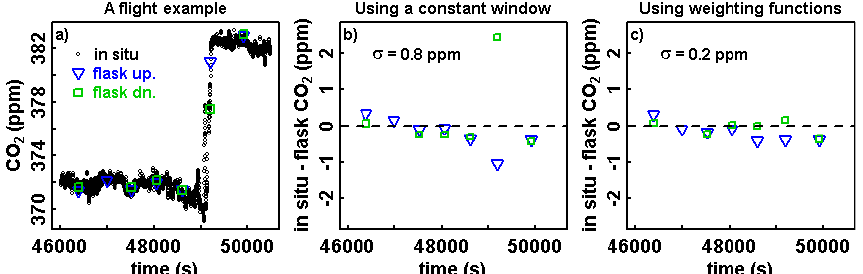
Fig. 8. An example of the performance of these weighting functions for the flight on 20 August 2008: (a) in situ measurements of CO 2 mixing ratios with flask CO 2 mixing ratios shown in blue (upstream) and green (downstream); comparison of flask data with the integrated signal of in situ continuous CO 2 measurements (b) using a constant 120-s window; (c) using the weighting functions, Eqs. (3.2) and (3.3).